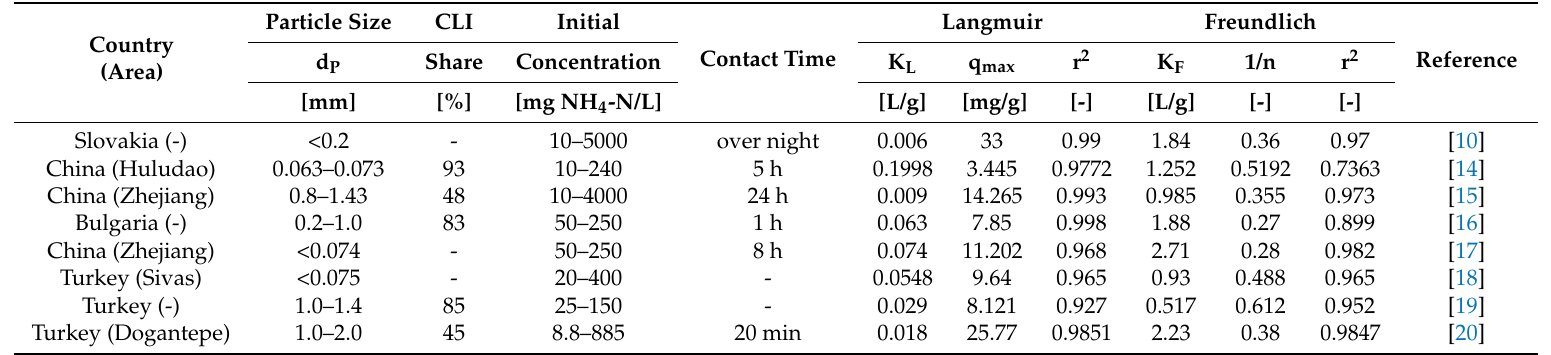
Table 1. Overview of constraints and coefficients of isotherms according to Langmuir and Freundlich in different studies investigating the adsorption of ammonium onto